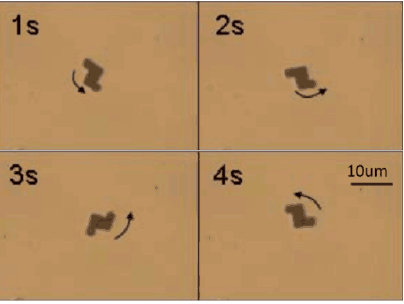
Figure 9. The continuous images of the Z-shaped hybrid Pt/Au hybrid nanorobot.